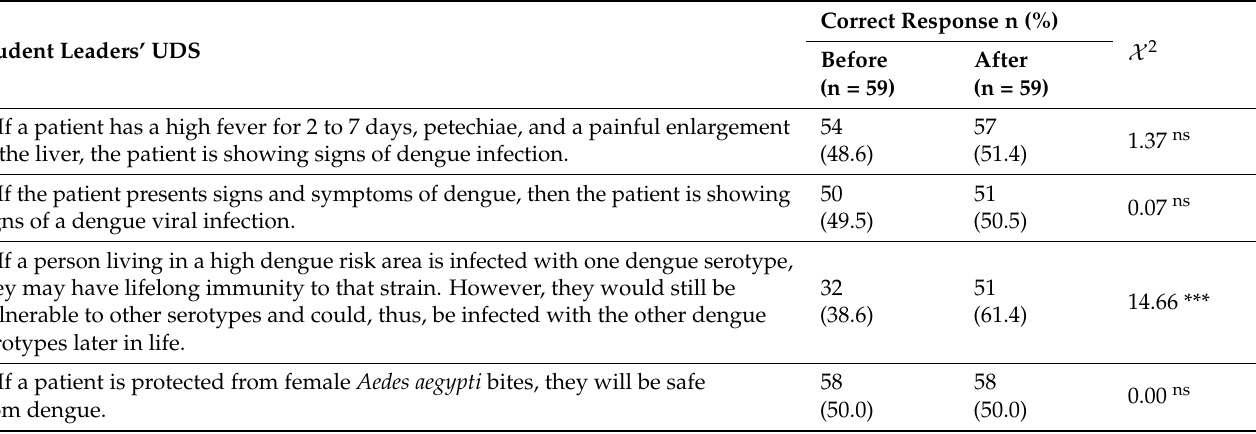
Table 8. Comparison of correct response rates regarding the UDS of student leaders before and after implementation of the training